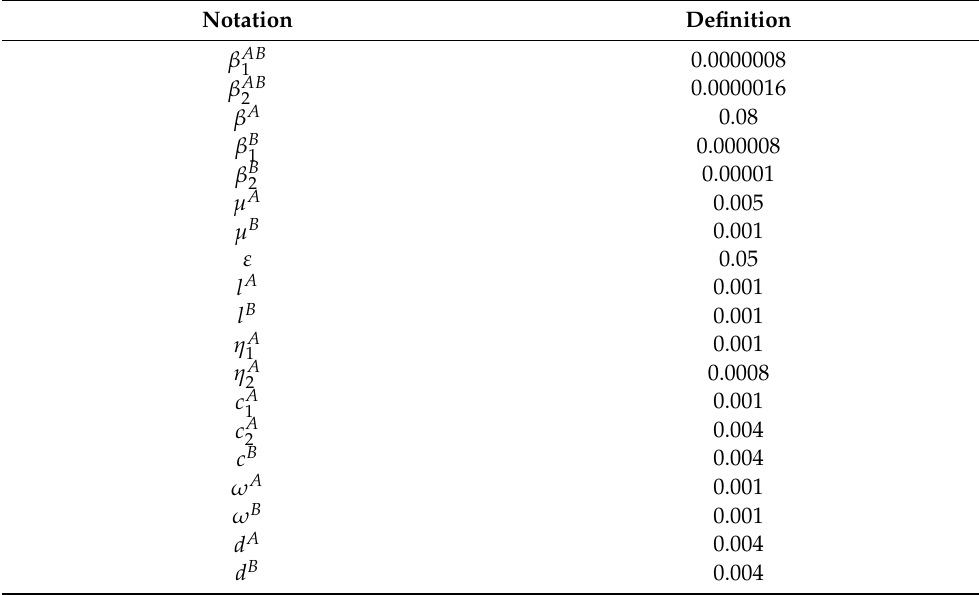
Table 5. Simulation parameters.